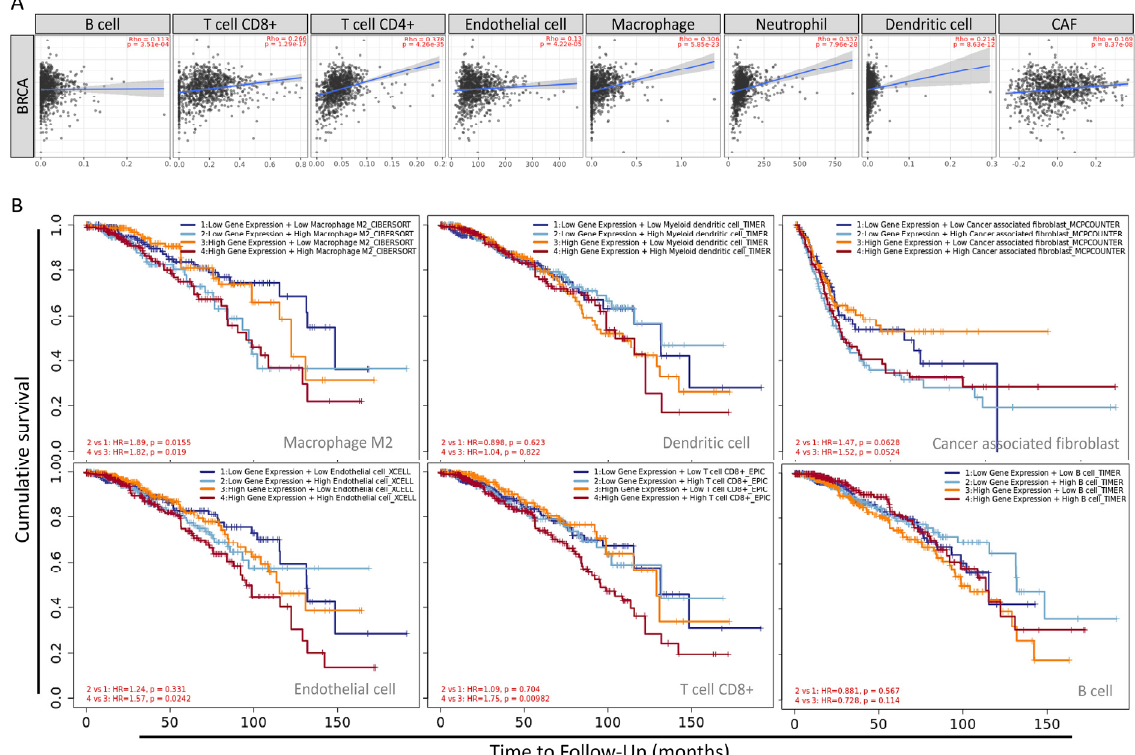
Figure 9. Systematical analysis of immune infiltrates associated with MARCH5 mRNA expression in BRCA using the Tumor Immune Estimation Resource. ( A ) Correlation of MARCH5 expression with immune infiltration level in BRCA. ( B ) Kaplan–Meier plots for immune infiltrates and MARCH5 mRNA expression to visualize survival differences in BRCA.